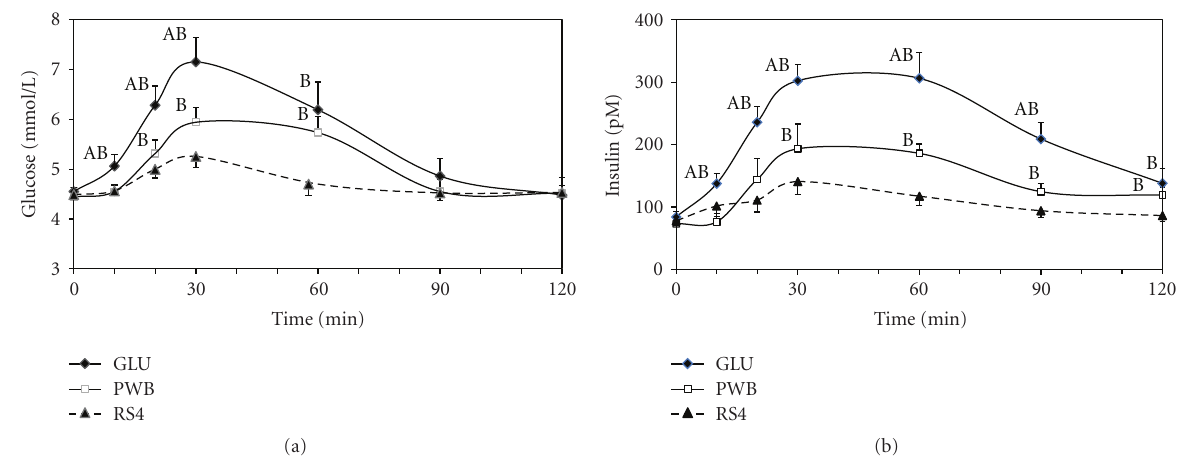
Figure 1: Depiction the glucose (a) and insulin (b) responses over two hours following the consumption of each (Glu, PWB, and RS4) treatment. Values represent each mean ± SE. A: significant di ff erence with PWB; B: significant di ff erence with RS4. of peak glucose and insulin, and significant di ff erences from baseline to peak and iAUC values glucose and insulin when compared with GLU and PWB (Table 3). The PWB bar attenuated the peak glucose and insulin responses and the iAUC for glucose and insulin compared with GLU. The percent increase from baseline to peak was not di ff erent ( P = . 068) from GLU for glucose, while it was for